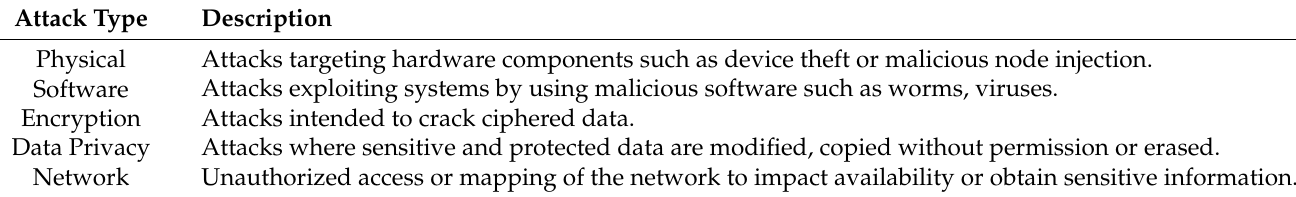
Table 3. Types of possible attacks. Adapted from